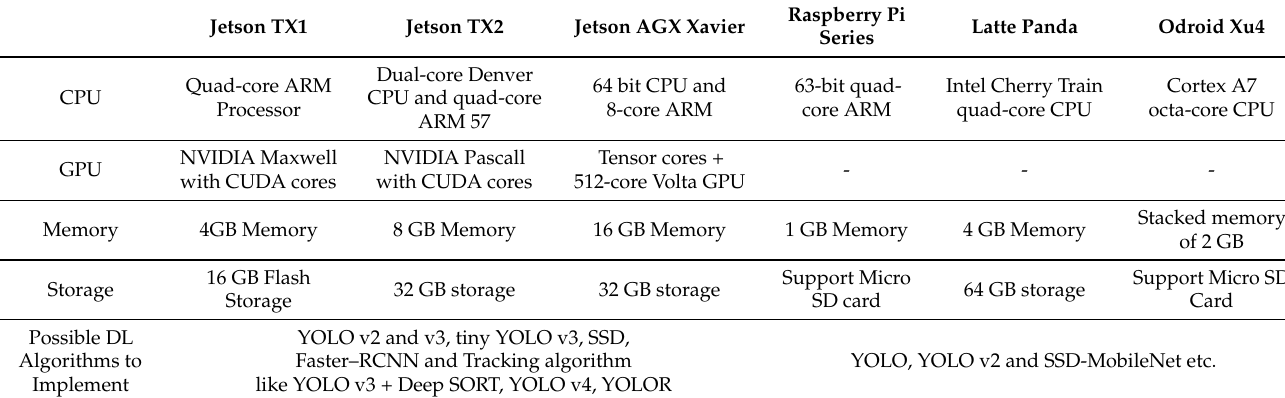
Table 11. Comparison between Jetson Modules and GPU-Constrained